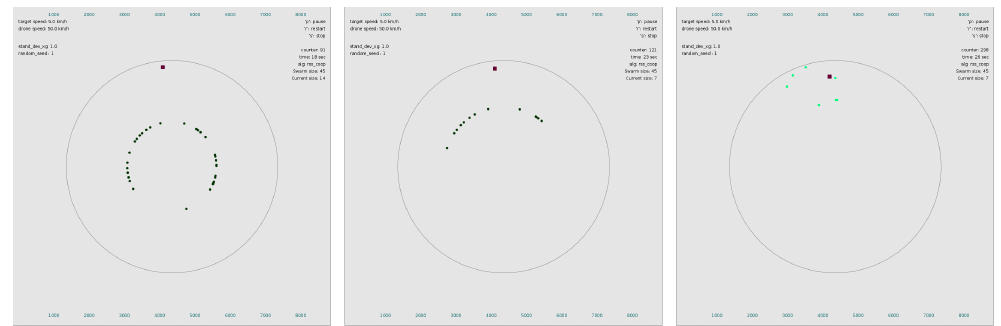
Figure 4. Simulator instances at different timestamps of the simulation. The red square represents the target sensor, and the dots indicate the UAVs. The left subfigure depicts the swarm 90 s after initiating the algorithm. The middle subfigure corresponds to 120 s, while the last subfigure demonstrates the tracing process after the threshold for terminating the DL procedure has been